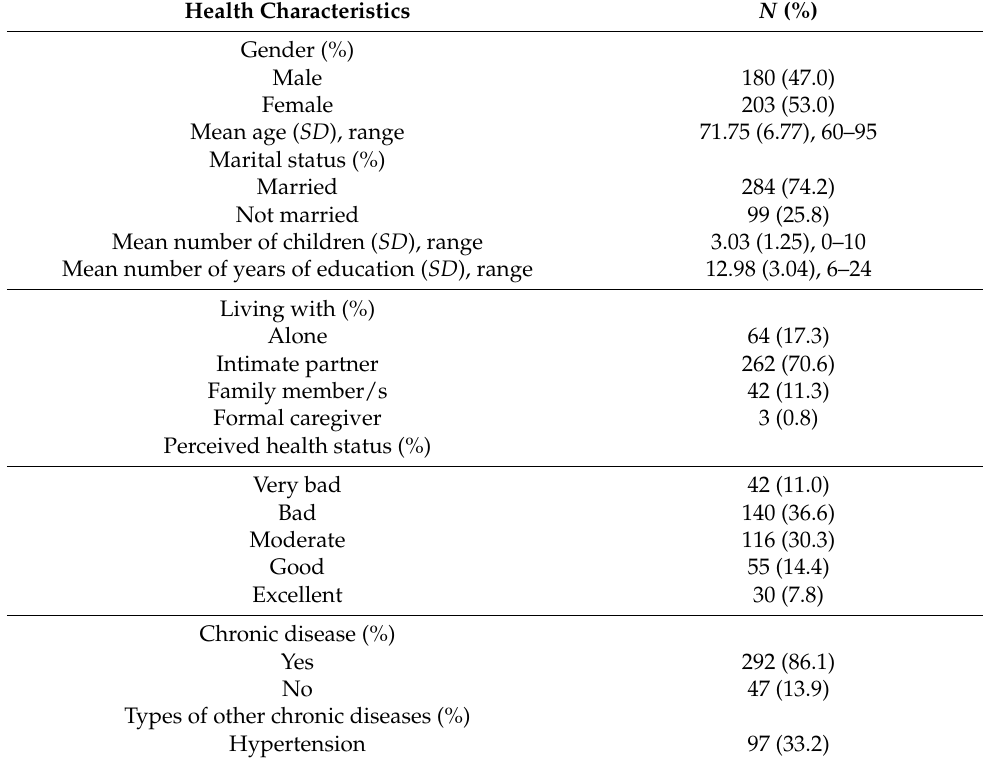
Table 1. Participants’ demographic characteristics ( N =